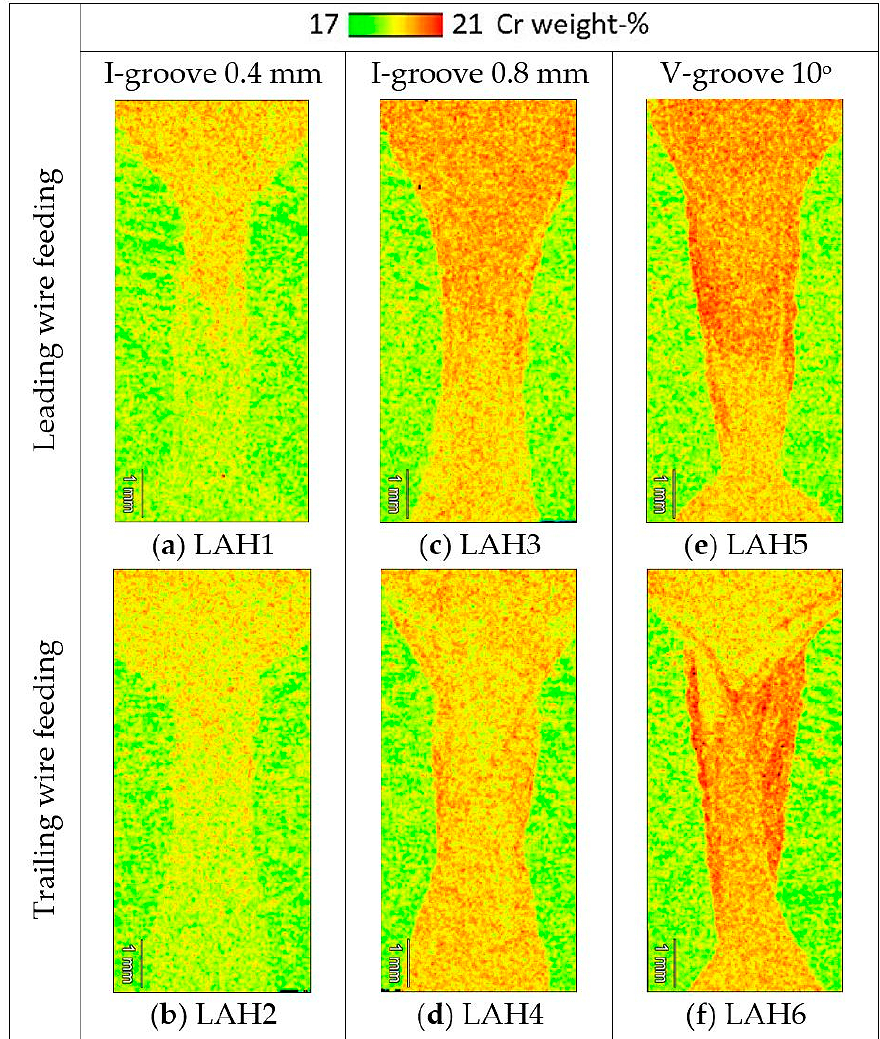
Figure 9. Energy dispersive spectroscopy (EDS) mapping images ( a – f ) showing the distribution of chromium in laser arc-hybrid test welds.